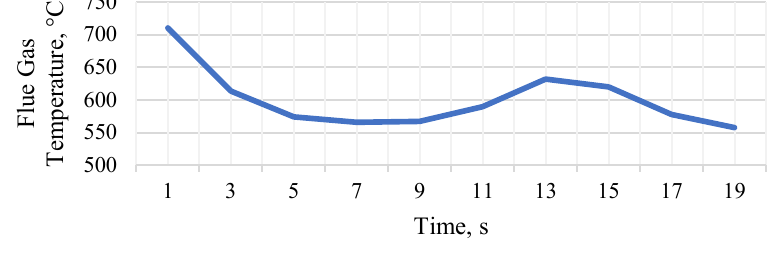
Fig. 2. Flue Gas Temperature Observation 1.